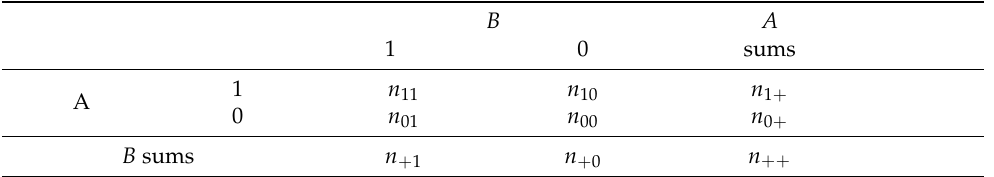
Table 5. 2 × 2 contingency table for binary variables A and B